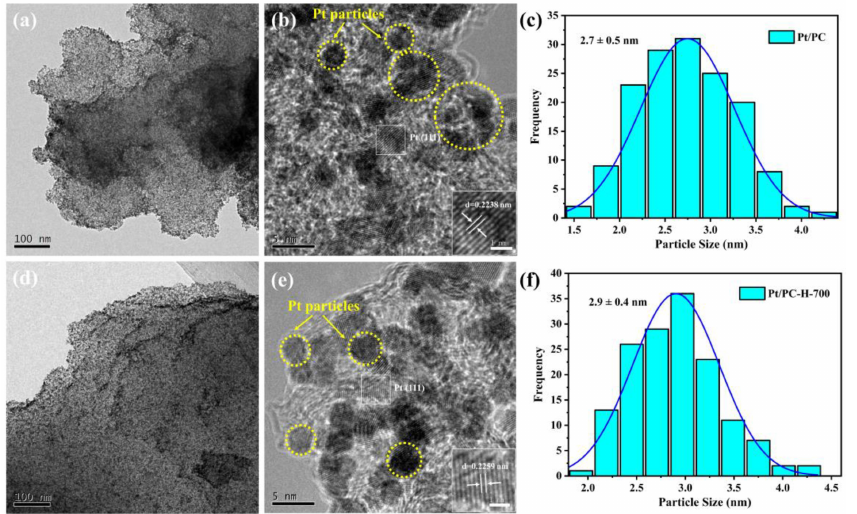
Figure 6. TEM and HRTEM images of Pt/PC ( a , b ), and Pt/PC-H-700 ( d , e ) catalysts. Pt size distribu- tions of Pt/PC ( c ), and Pt/PC-H-700 ( f )